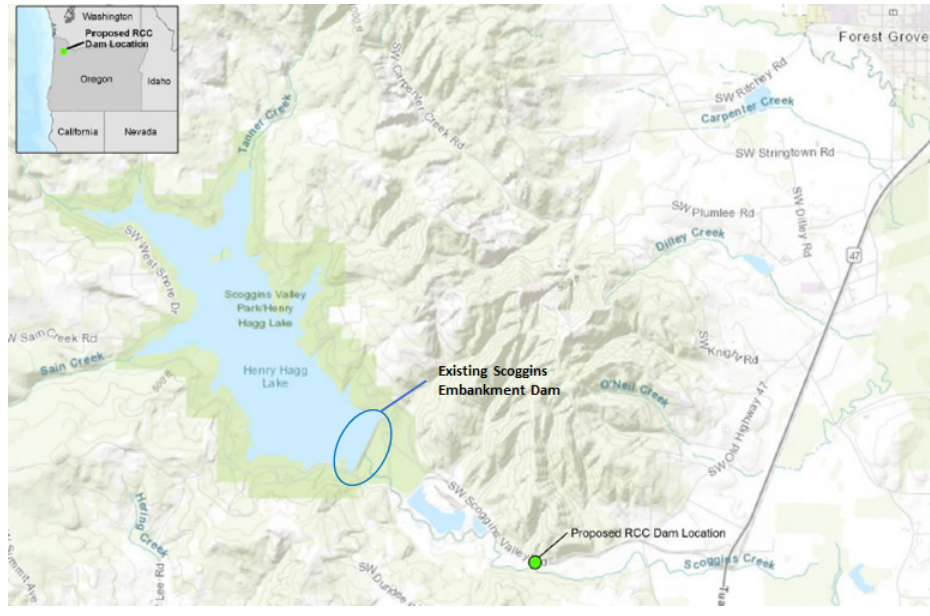
Figure 1. Project location map.